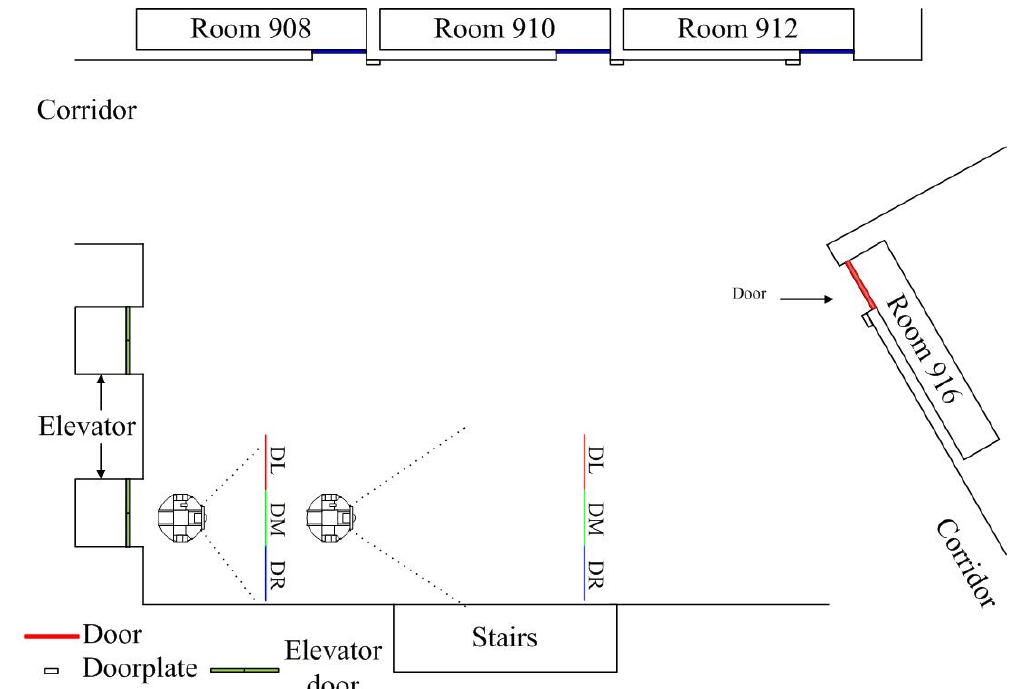
Figure 18. Target is not detected, thus the robot turns left to find the room color.